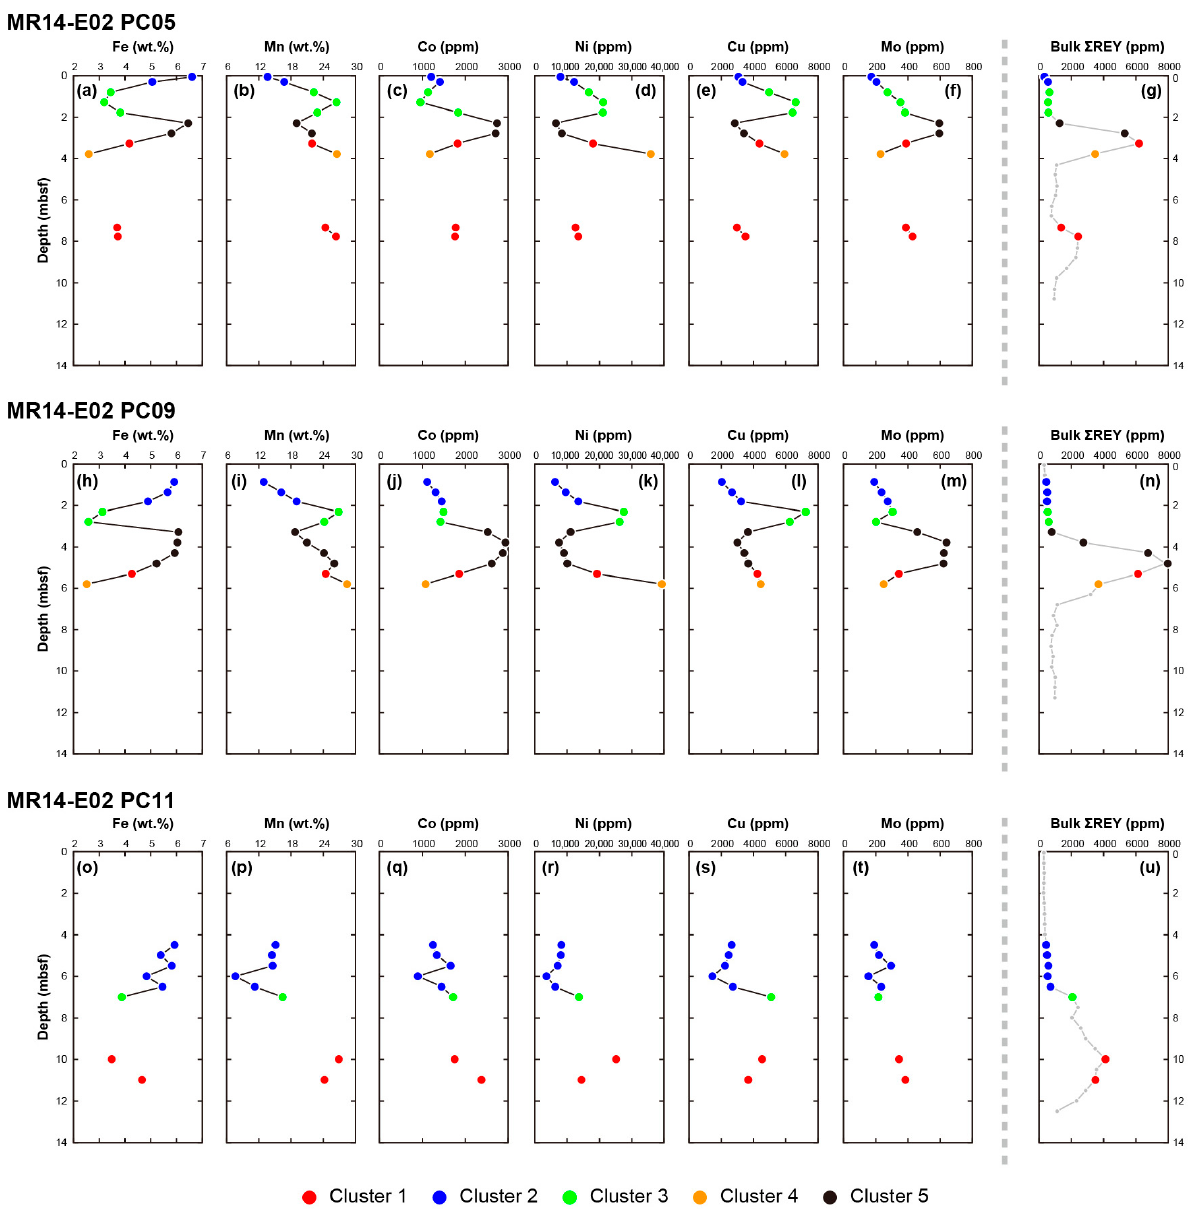
Figure 4. Downcore variations of the key element contents colored by clusters ( K = 5) ( a – f , h – m , o – t ). The Σ REY contents of the bulk sediments and the clustering based on the Fe–Mn micronodule composition are also shown for comparison ( g , n , u ).